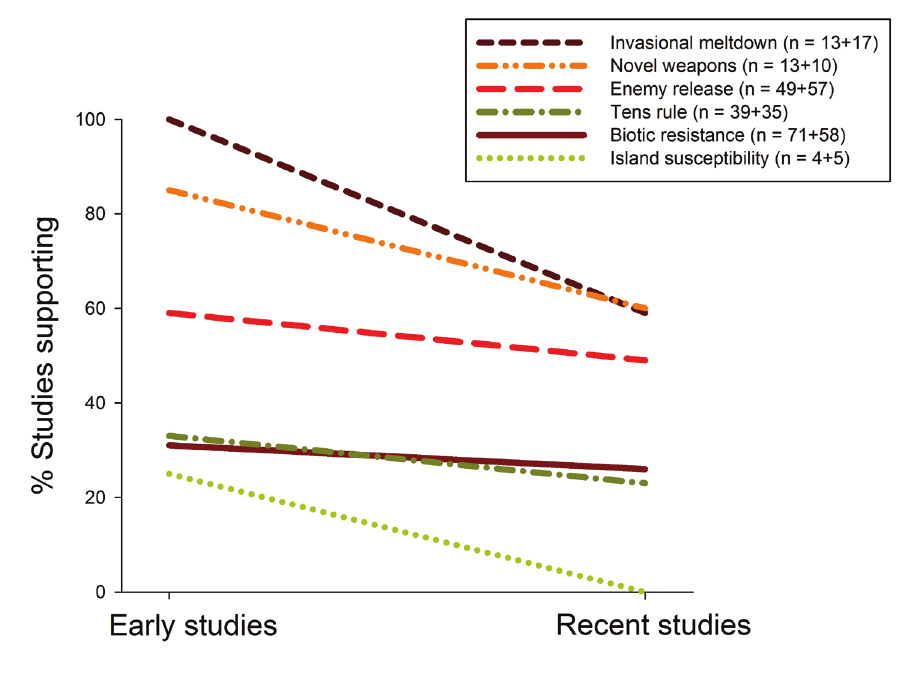
Figure 3. Level of empirical support for six of invasion biology’s major hypotheses, subdivided for early and recent studies. Numbers of early and recent studies for each hypothesis are provided in the legend. To improve the figure’s clarity, only % studies supporting each hypothesis are shown here, and other studies are not further divided into those questioning and being undecided about each hypothesis (as in Figs 2, 4, 5). When statistically testing for a decline effect, however, all three levels of empirical support (supported, undecided, questioned) were considered. The decline effect shown here is statistically significant (General- ized Linear Model, likelihood ratio test, p <